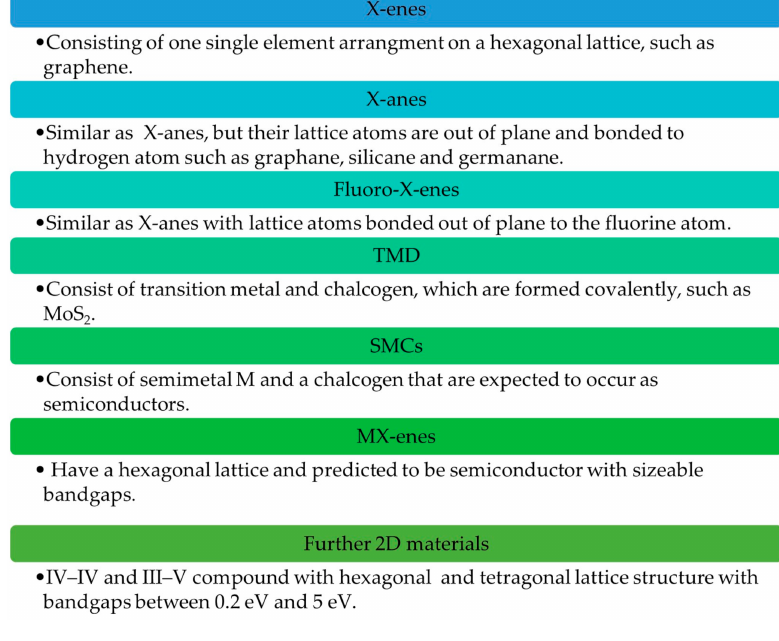
Figure 2. Classification of 2D materials (adapted from [21]).